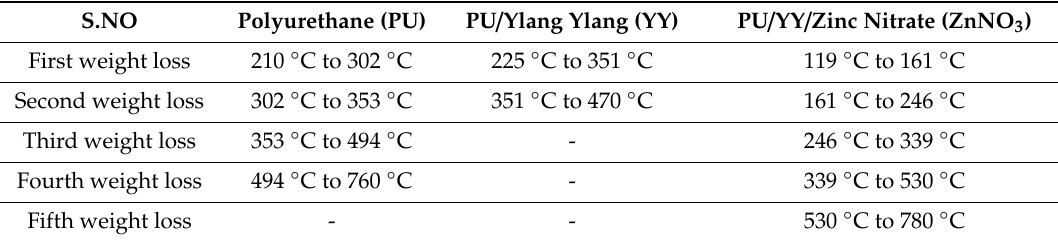
Table 1. Weight loss peaks of the electrospun membranes.